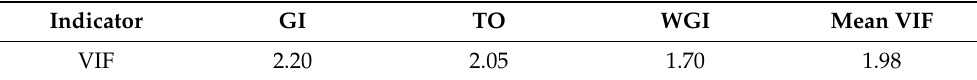
Table 4. The empirical results for the variance inflation factor